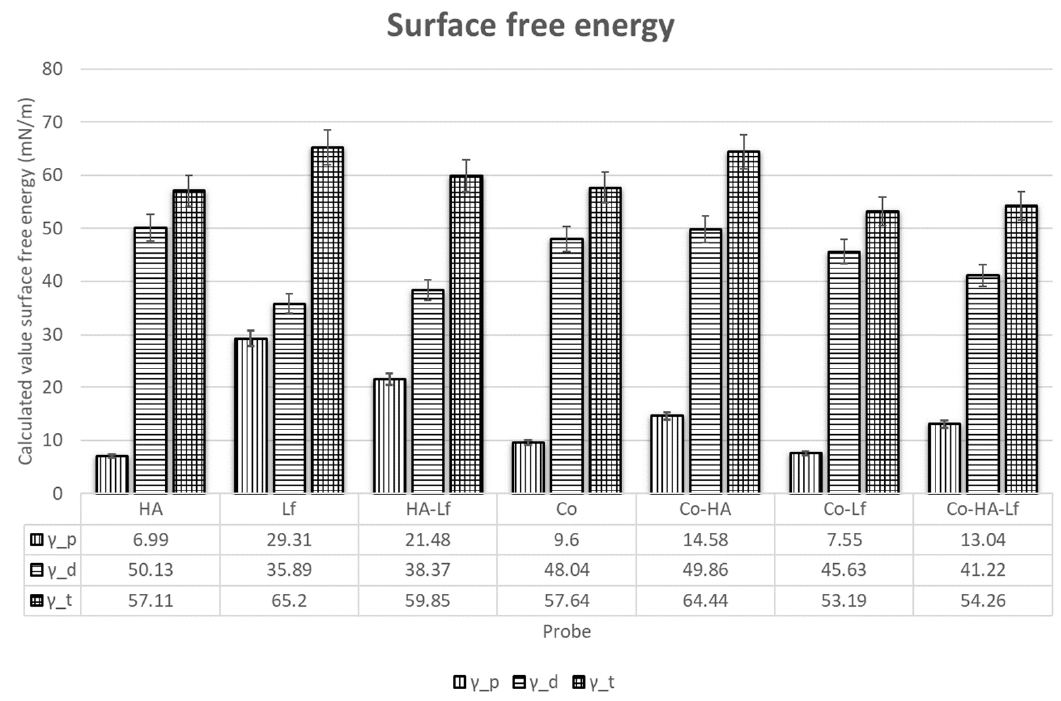
Figure 5. Histogram presenting the total surface free energy, disperse and polar parts.